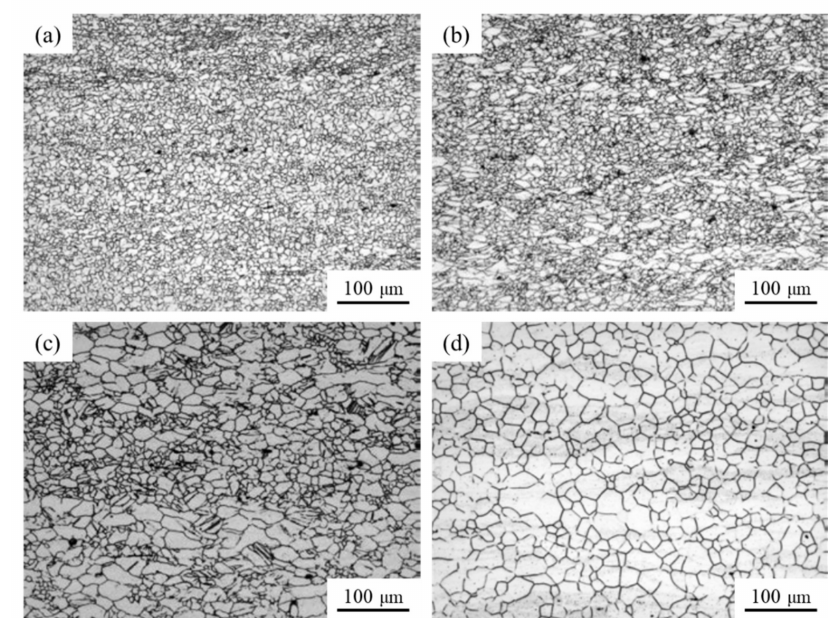
Figure 2. Microstructure of the Mg-2Zn-0.4Y alloy after the 1st rolling process at. ( a ) 250 ◦ C-plate A;